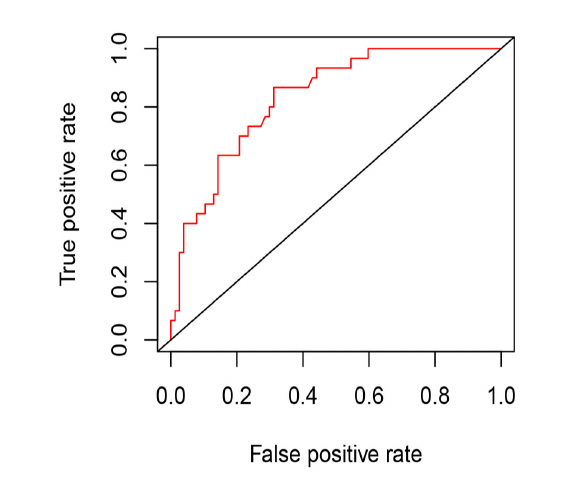
FIGURE 6 The ROC curve of the model for predicting residue of PCTNs after thermal ablation. AUC=0.832, optimal cutoff value=0.2 (speci fi city: 68.8%, sensitivity: 86.7%).